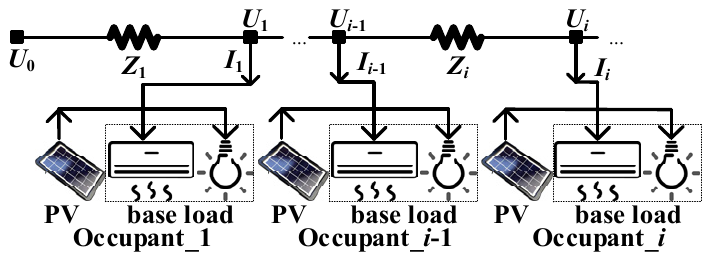
Figure 5. The simple distribution network model.